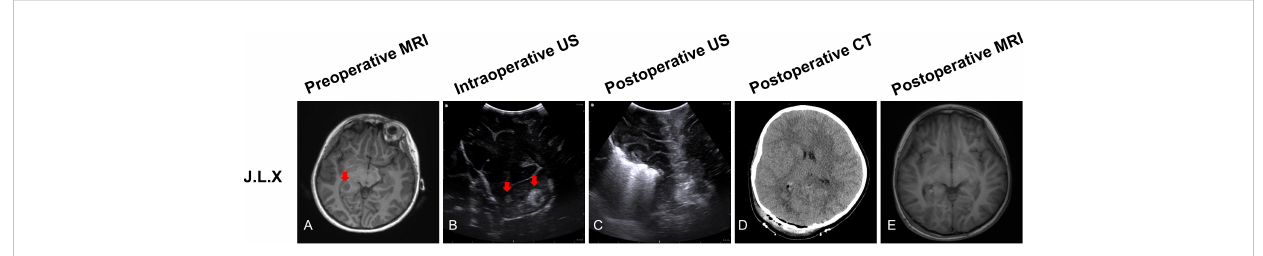
FIGURE 4 Illustrating case 3: J.L.X, a 7-year-old girl, MRI (T1WI) sequences showed one tumor located at the right periventricular ( A , red arrow). Before opening the dura, IoUS found two hyperechoic signals (two tumors) in the operative fi eld ( B , red arrow). After the resection, the doctor used the ioUS to check the surgical fi eld, and no tumor remnants were found (C) . The postoperative CT scan reveals no tumor remnants (D) . No tumor remains are visible on the postoperative MRI (T1WI) scan (E) . Histopathology indicated recurrent WHO grade 3 glioma.